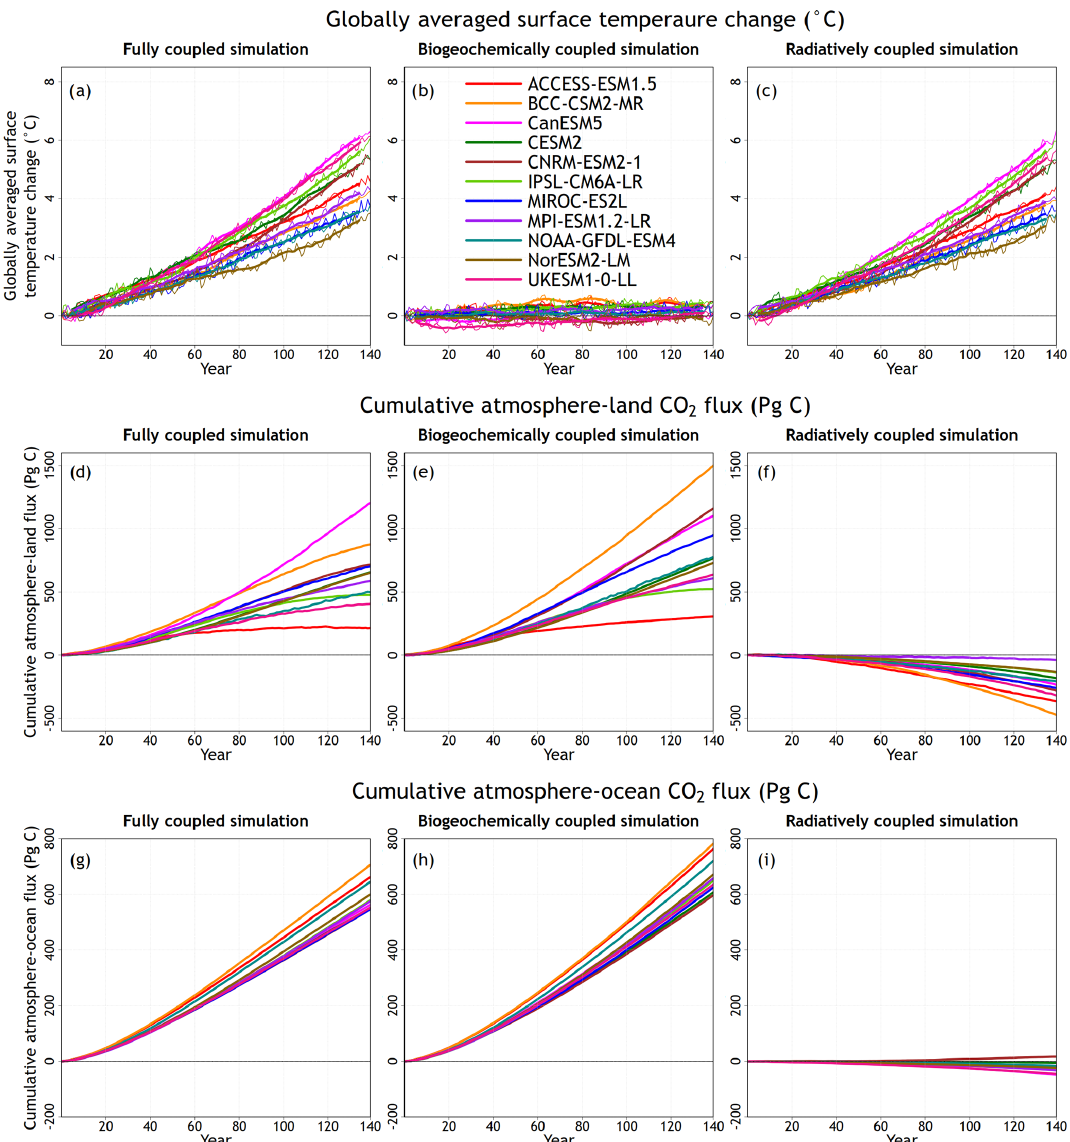
Figure A1. Individual model values from CMIP6 models for globally averaged surface temperature change (a–c) , cumulative atmosphere– land CO 2 flux (d–f) , and cumulative atmosphere–ocean CO 2 flux (g–h) from the fully, biogeochemically, and radiatively coupled versions of the 1pctCO2